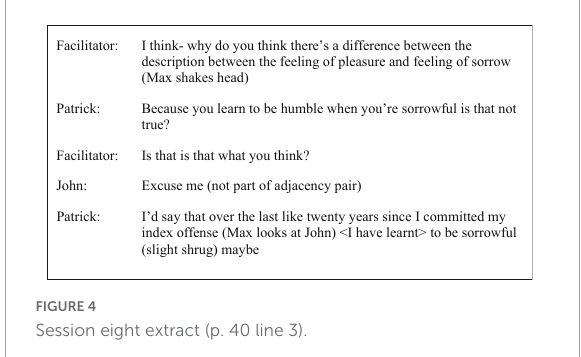
FIGURE4 Session eight extract (p. 40 line